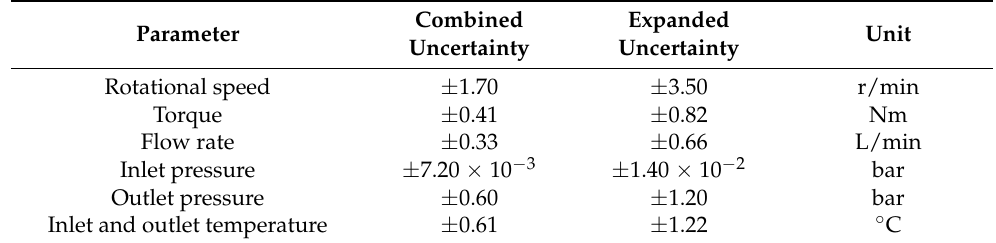
Table 3. Uncertainty values of measurement parameters. Coverage factor used in calculating expanded uncertainty k =